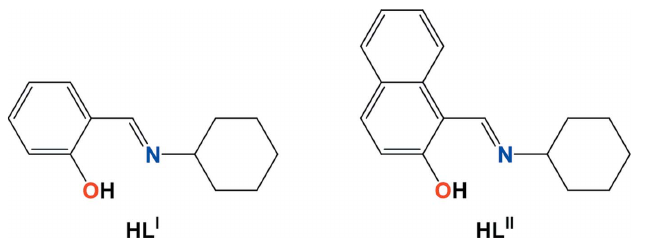
Figure 1 Diagrams of the applied Schiff base